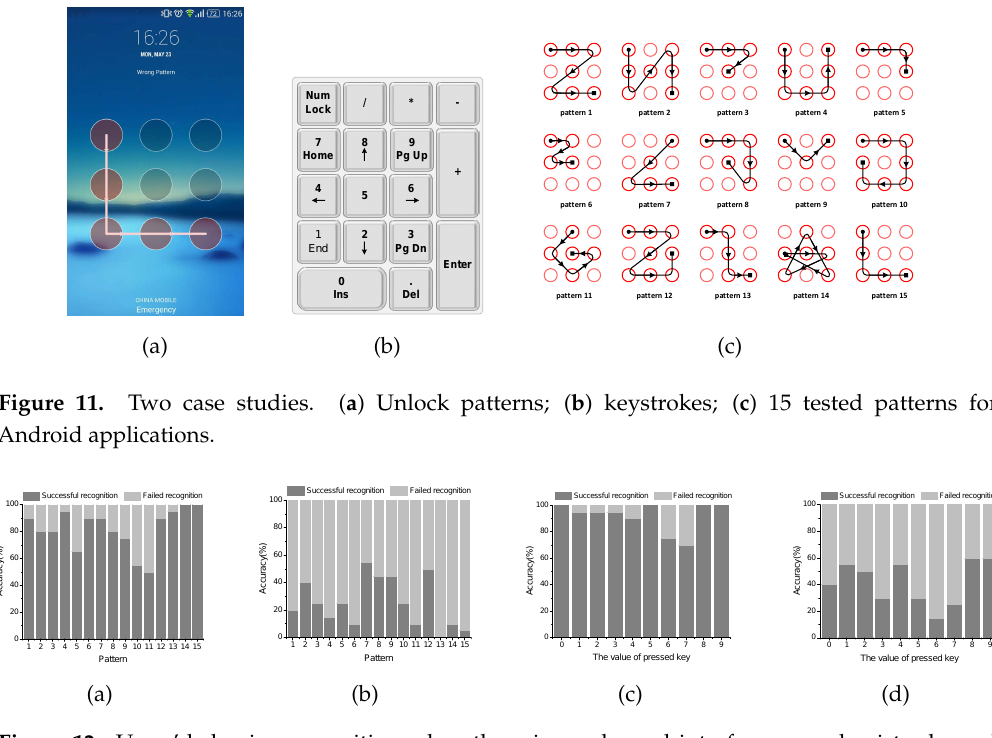
Figure 12. Users’ behavior recognition when there is no channel interference and exists channel interference. ( a ) Pattern recognition without interference; ( b ) pattern recognition with channel interference; ( c ) keyboard recognition without interference; ( d ) keyboard recognition with channel